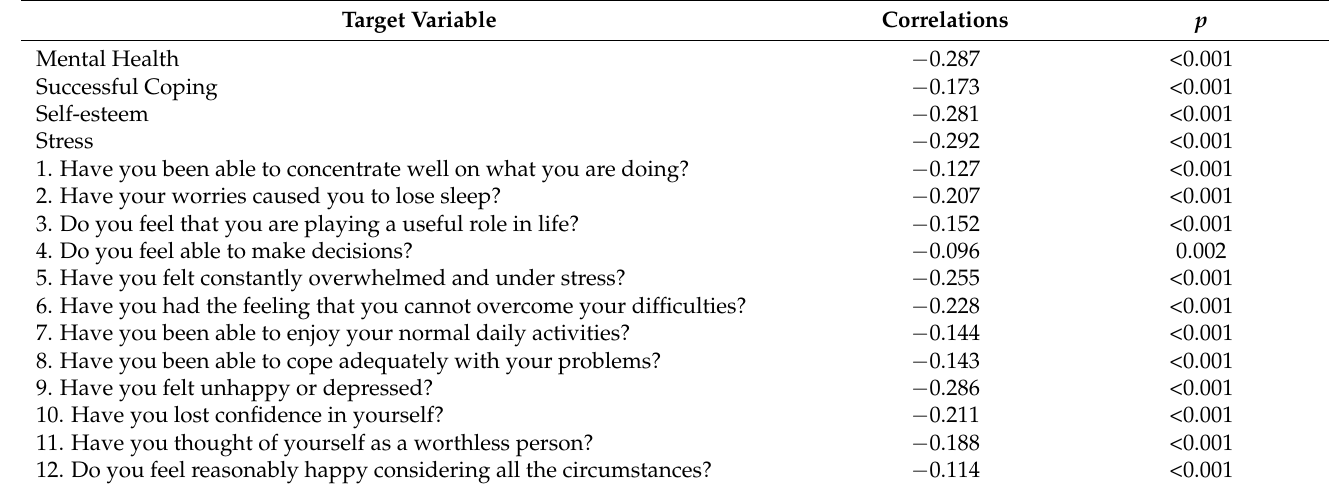
Table 4. Correlation between Pelf Perceived Support (SPP) and mental health in Spanish adults with Asthma, according to the ENSE2017.